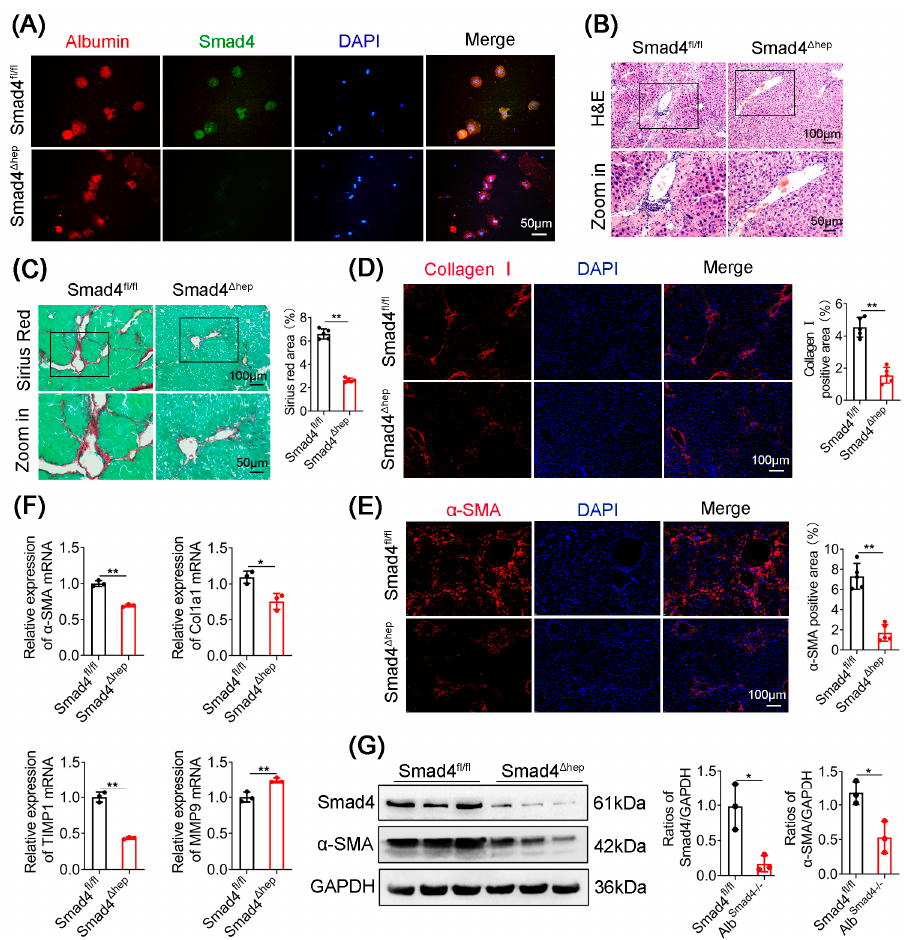
Figure 2. Hepatocyte-specific Smad4 deficiency attenuates liver fibrosis. Smad4 fl/fl and Smad4 ∆ hep mice were treated with CCl 4 for 4 weeks to establish a liver fibrosis model ( n = 6 per group). ( A ) Double staining of Albumin (red) and Smad4 (green) in primary hepatocytes (scale bars: 50 µ m). ( B ) H&E staining of fibrotic liver tissues (scale bars: 100 µ m, zoom in: 50 µ m). ( C ) Sirius Red staining of fibrotic liver tissues (scale bars: 100 µ m, zoom in: 50 µ m), quantification of stained areas, and statistical analysis. ( D , E ) Immunofluorescence detection of collagen Ⅰ and α -SMA in fibrotic liver tissues (scale bars: 100 µ m), quantification of stained areas, and statistical analysis. ( F ) The mRNA levels of α -SMA, Col1a1, TIMP1, and MMP9 in fibrotic liver tissues were measured using qRT-PCR analysis. ( G ) Western blotting analysis of Smad4 and α -SMA protein levels in fibrotic liver tissues. Protein density was quantified using densitometry. α -SMA and Smad4 levels were normalized to GAPDH. * p < 0.05, ** p <